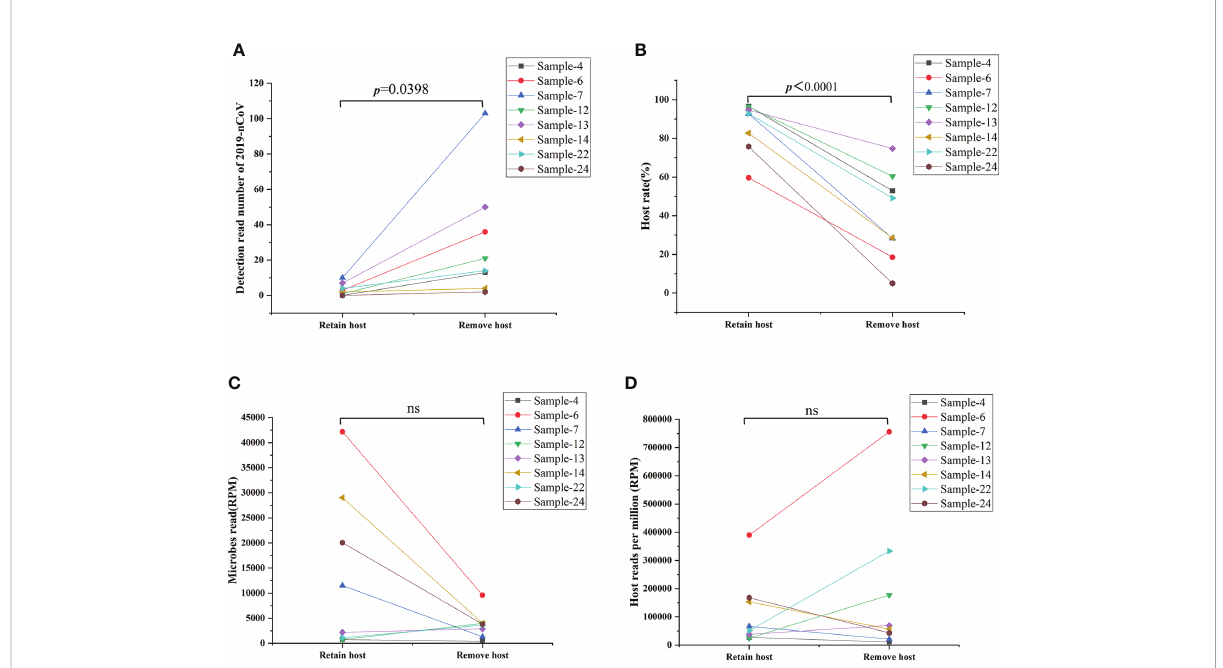
FIGURE 3 Comparison results from removing host and retaining host work fl ow. (A) Removing the host signi fi cantly improved the detection read number of 2019-nCoV ( p <0.05). (B) Removing the host decreased signi fi cantly the host rate in the swab sample ( p <0.05). (C, D) Removing the host on the detection reads of microbes reads and the host reads varies in different samples. RPM: Numbers of mapped reads per million; ns: no signi fi